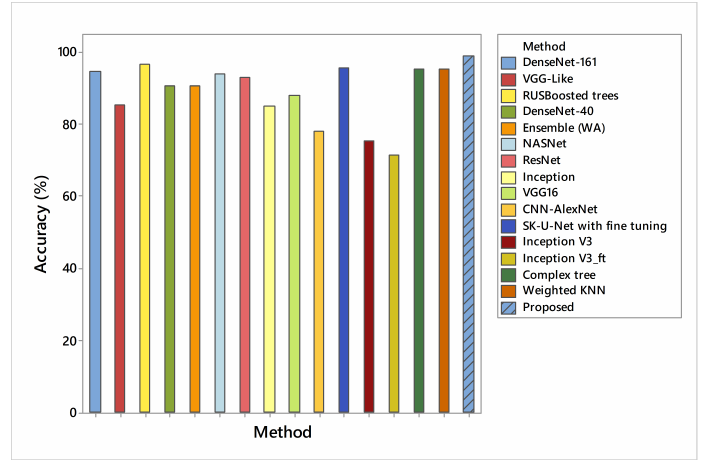
Figure 13. Accuracy comparison of Di-CNN with recent state-of-the-art algorithms on the same